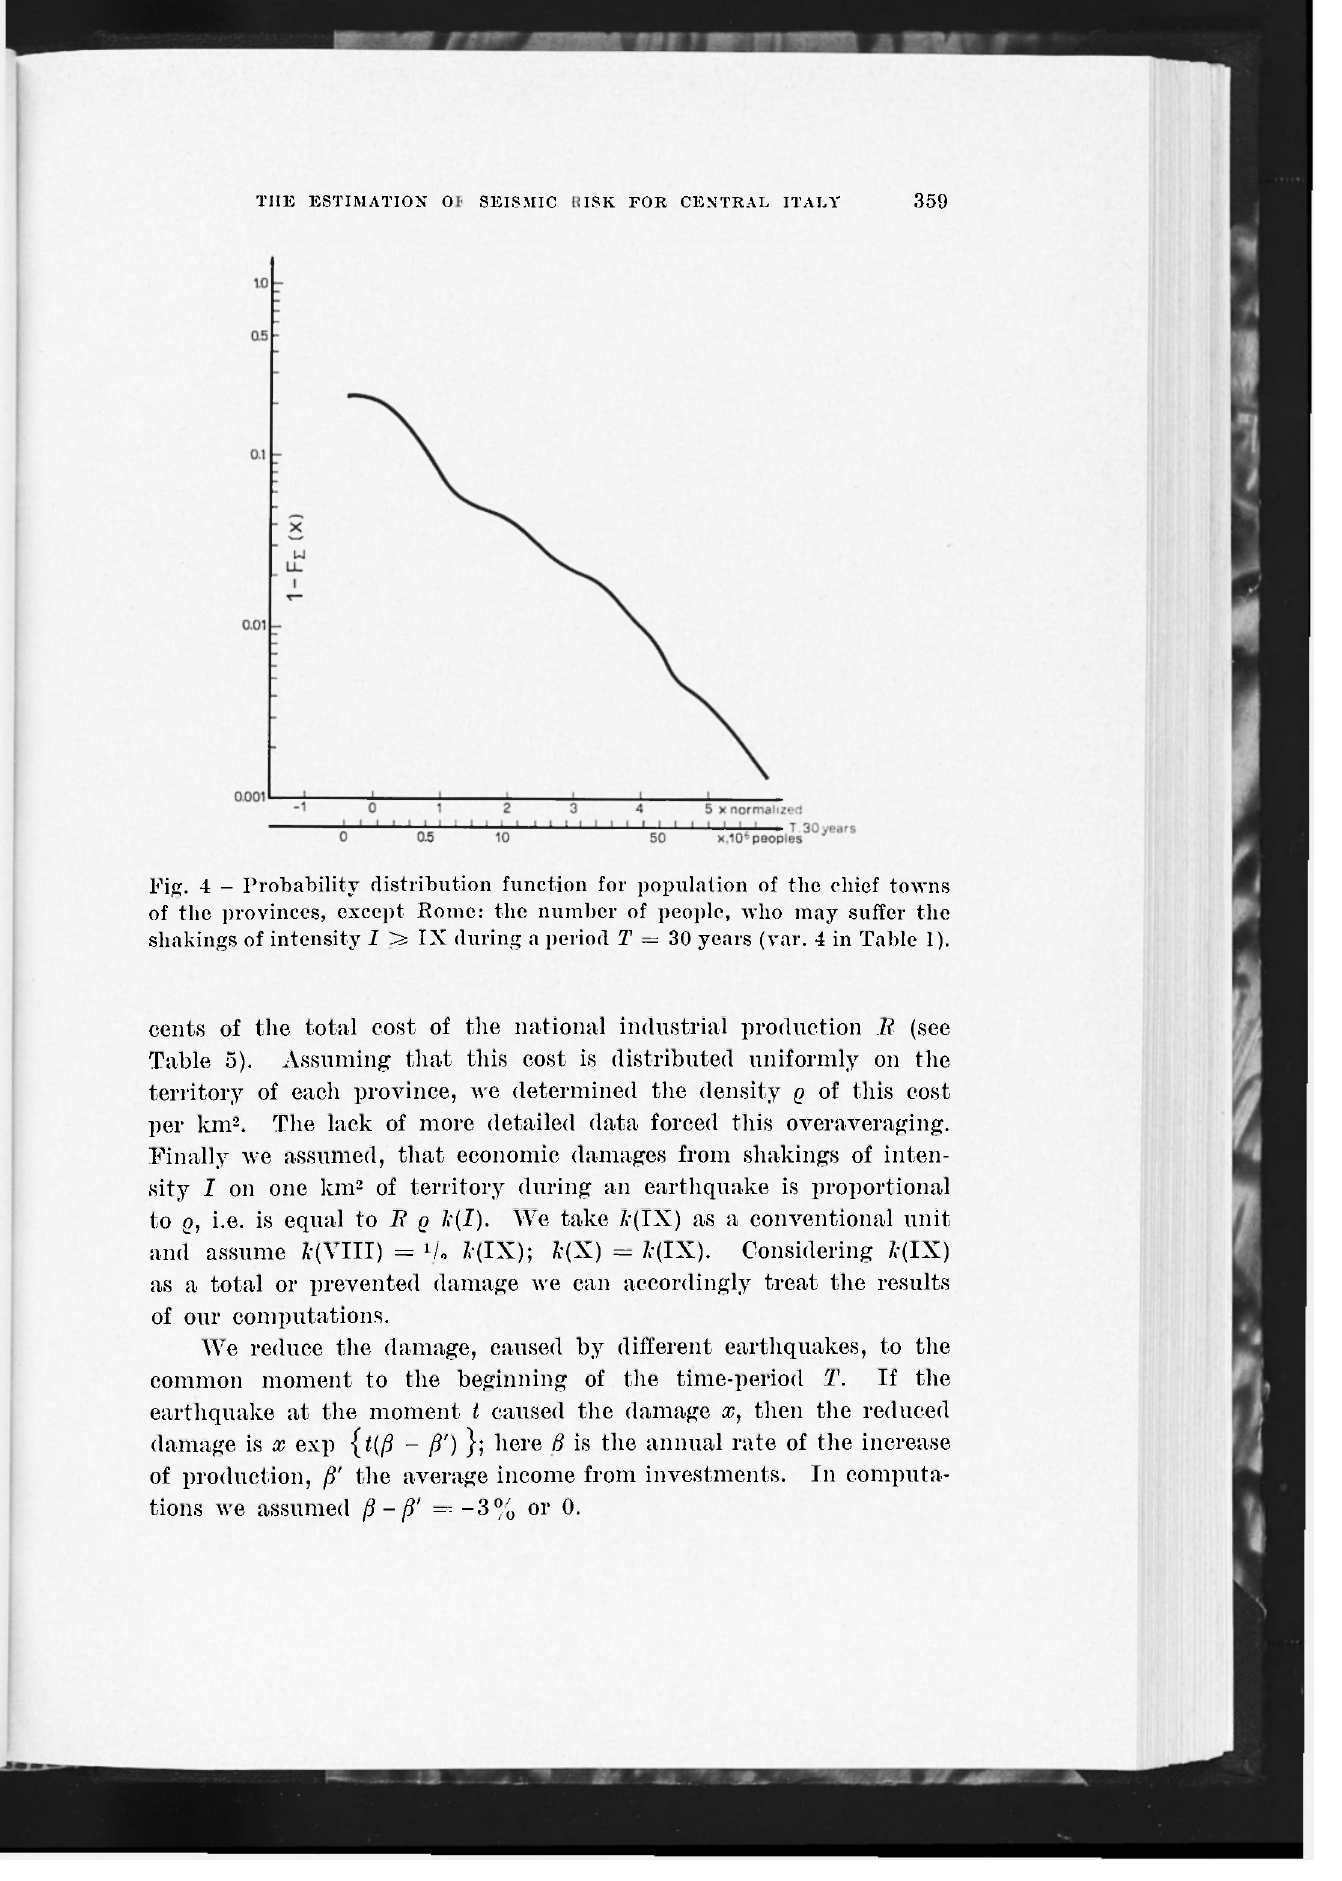
Fig. 4 - Probability distribution function for population of the chief towns of the provinces, except Rome: the number of people, who may suffer the shakings of intensity I IX during a period T = 30 years (var. 4 in Table